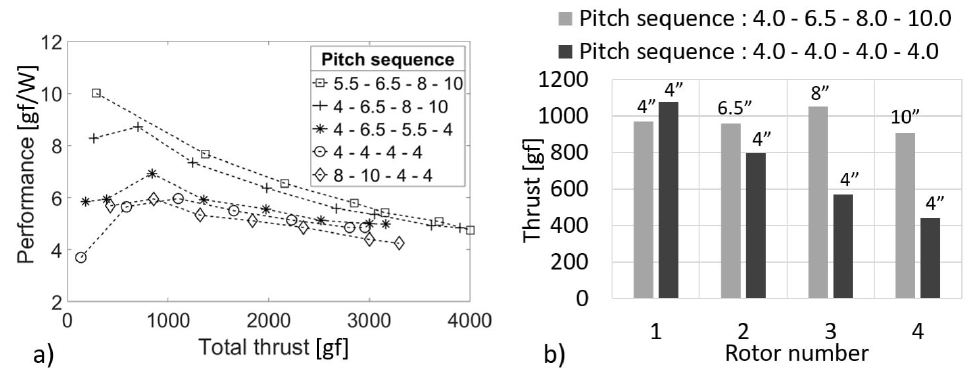
Figure 13. ( a ) System performance of four-rotor coaxial system for different pitch combinations. ( b ) Thrust distribution among rotors for sequentially increasing and constant pitch